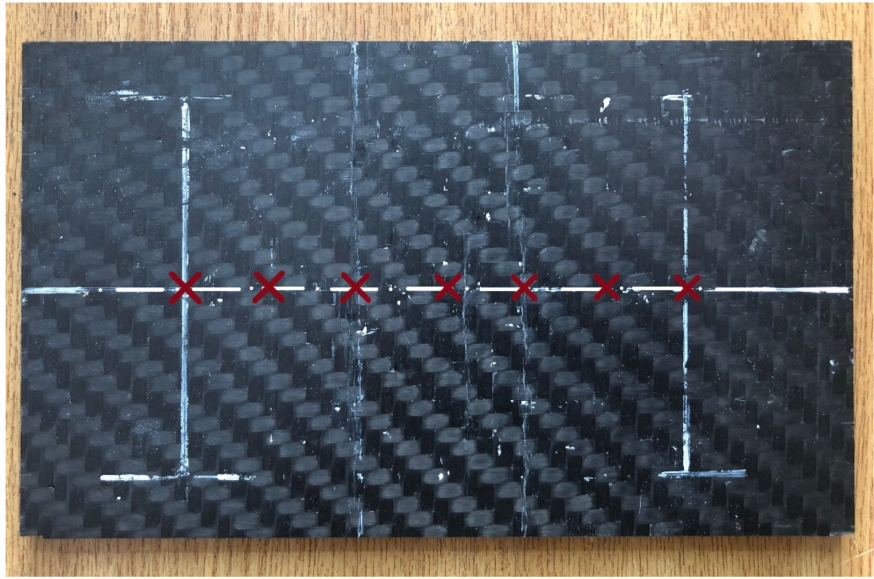
Figure 2. Location of impacts for DI d